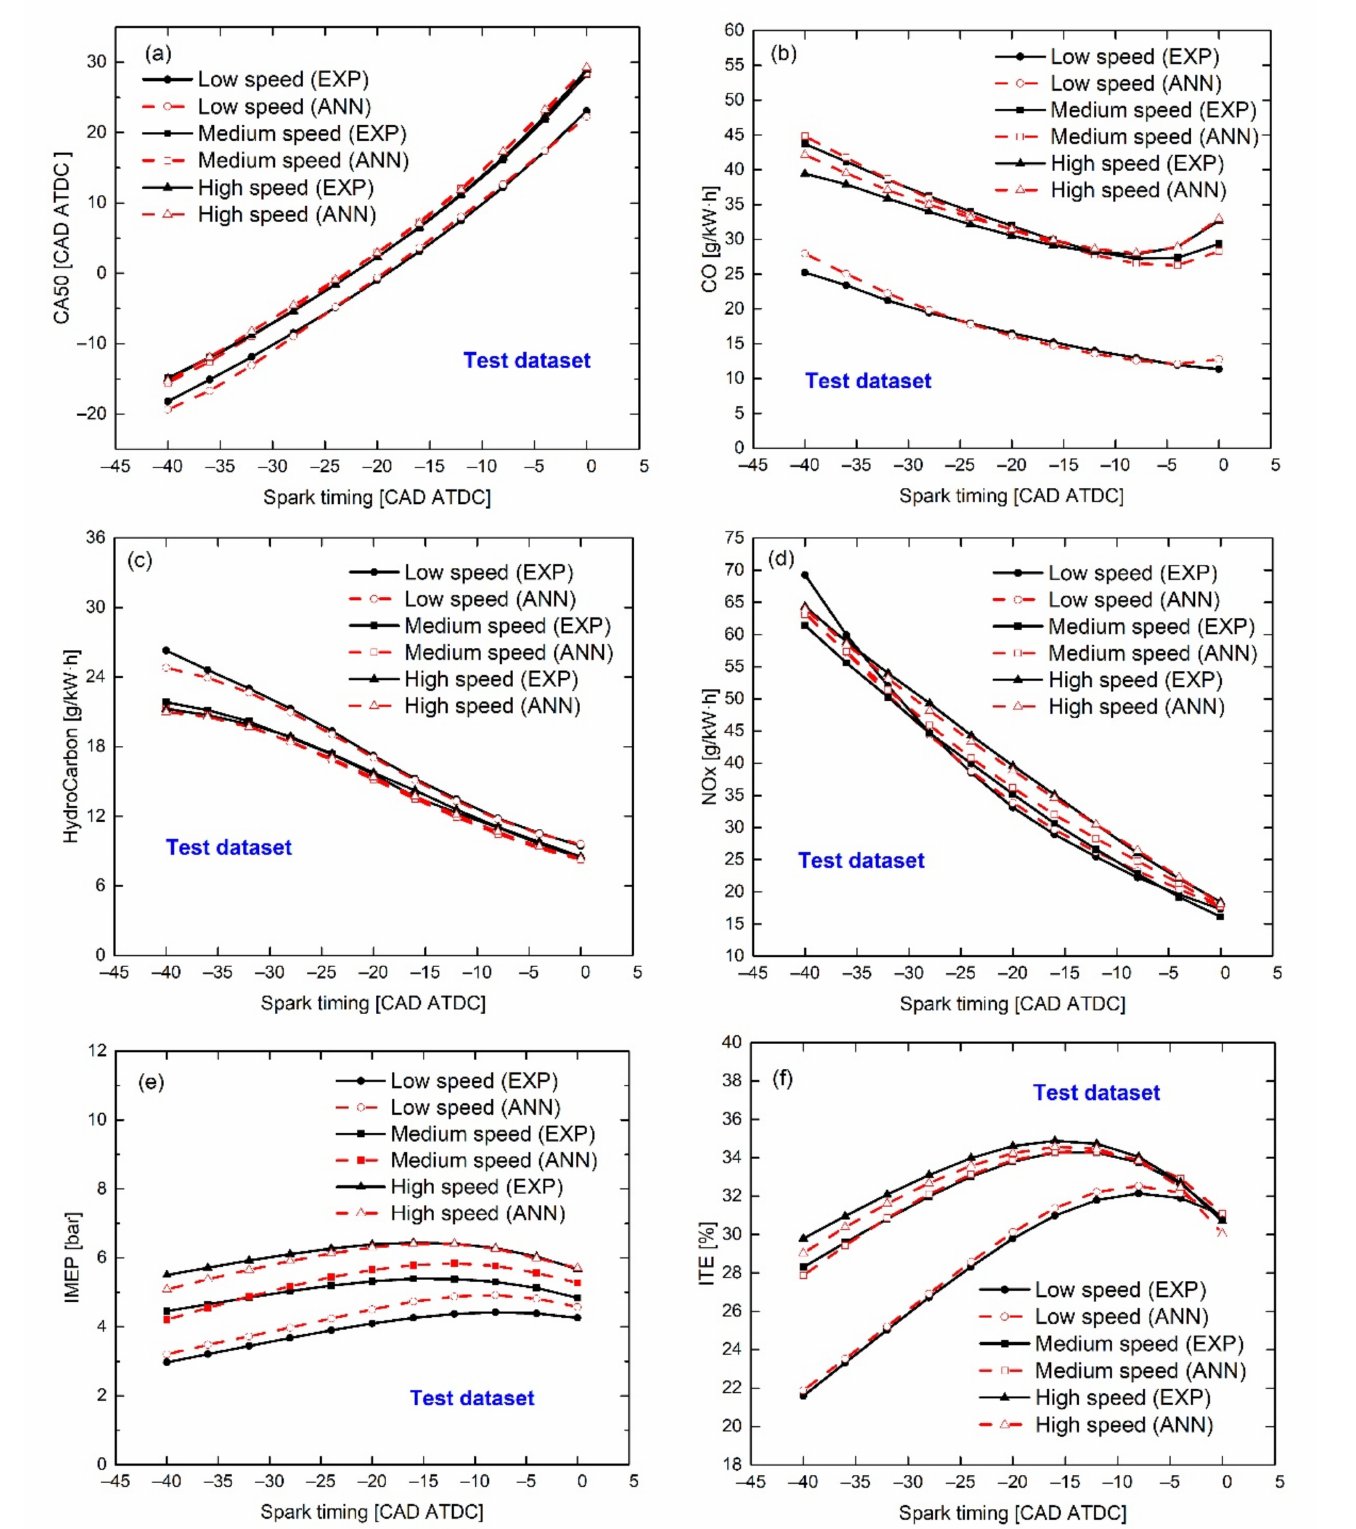
Figure 5. Comparison of ANN model predicted performance and emissions with calibrated data under low load for the steady test dataset: spark timing effects: ( a ) CA50, ( b ) CO, ( c ) UHC, ( d ) NOx, ( e ) IMEP, ( f )